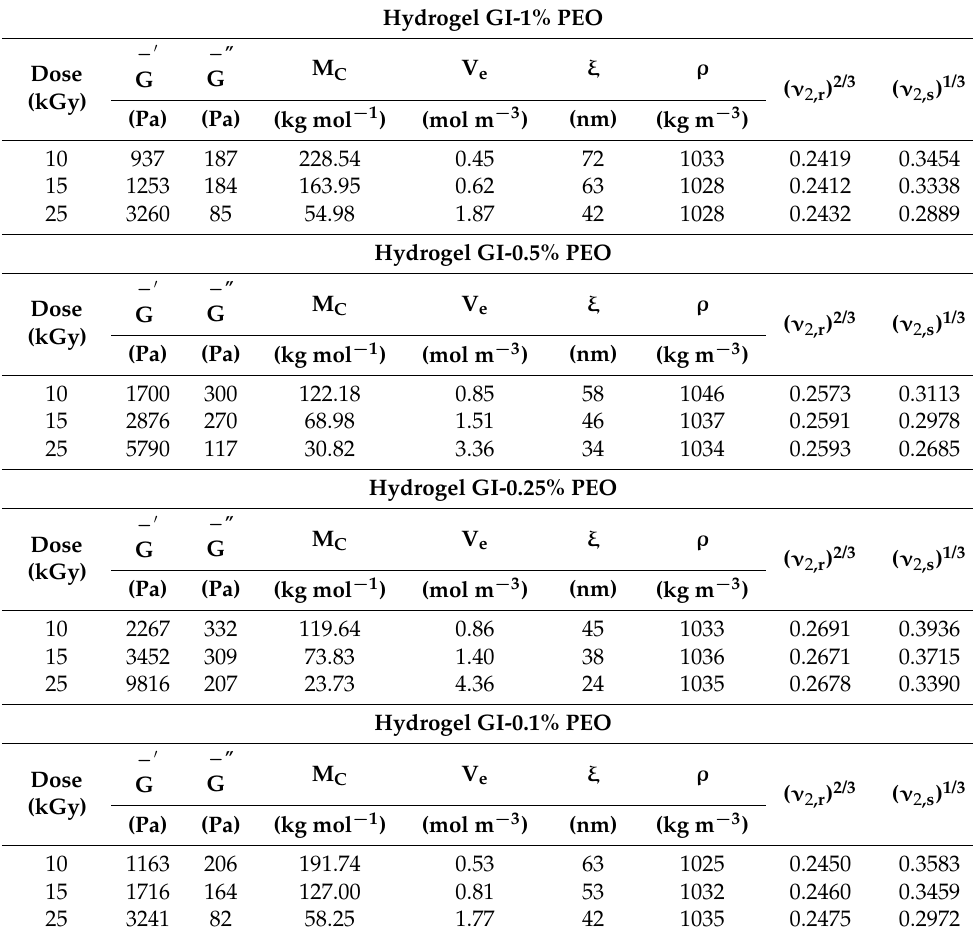
Table 4. Experimental values for G (cid:48) , G”, M C , V e , ξ and ρ . Hydrogel GI-1%